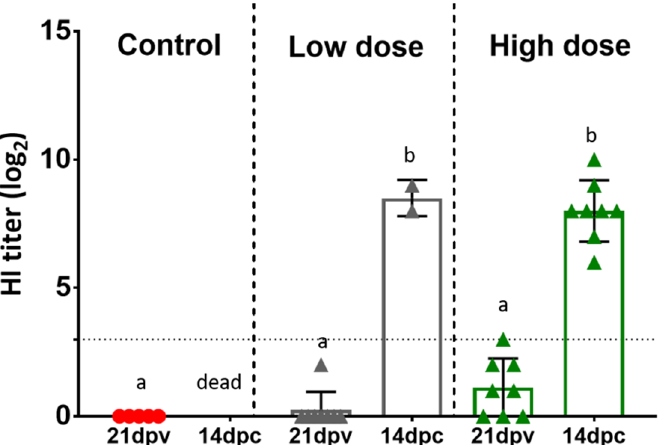
Figure 4. Antibody titers before and after challenge with CA02 virus. The hemagglutination inhi- bition (HI) test was performed in sera from non-vaccinated birds and birds vaccinated with adeno-F at low and high doses before and after challenge with CA02. No significant difference was detected comparing all groups before or after challenge. Different letters (a or b) are statistically significant. dpv: days post-vaccination, dpc: days post-challenge.